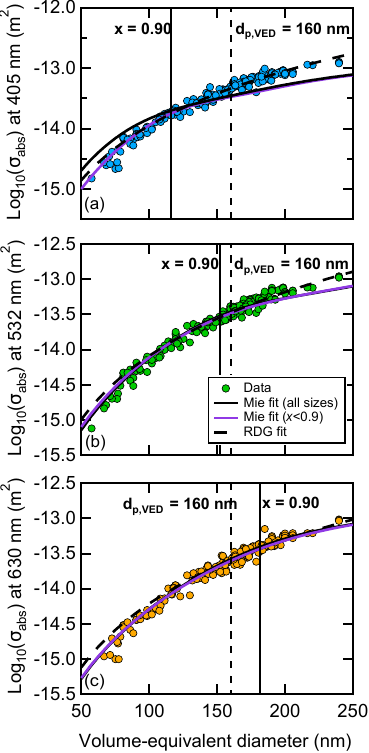
Figure 2. Observed σ abs vs. d p,VED methane soot data from BC3, BC3 + , and BC4. Panels (a) and (b) are λ = 405 and 532nm data, respectively, from the UCD CRD-PAS, and (c) is λ = 630nm data from the CAPS PM SSA . The nascent and coated–denuded data have been combined since there is no significant difference in the absorp- tion cross sections and MACs between the two datasets. Note the inability of Mie theory to reproduce the observed σ abs,405nm for all sizes. Vertical solid lines indicating x = 0 . 9, where observations deviate from Mie theory, are provided for reference. In addition, vertical dashed lines indicate d p,VED = 160nm, above which soot maturity is approximately